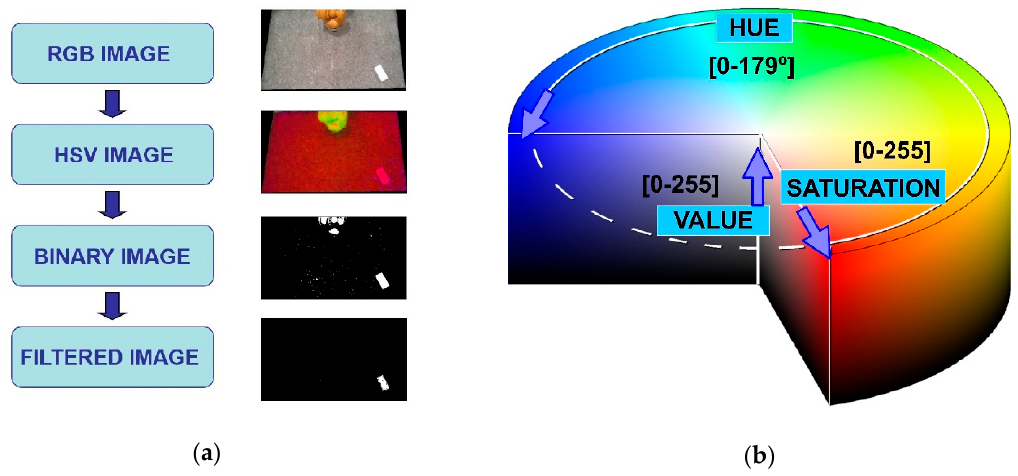
Figure 4. Image processing used in the machine vision module: ( a ) Main workflow for image processing; ( b ) HSV color space used for obstacle detection (scales available in OpenCV-3.1 library).